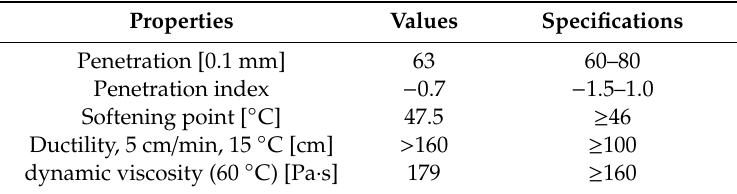
Table 1. Basic properties of the asphalt binder used in this work.